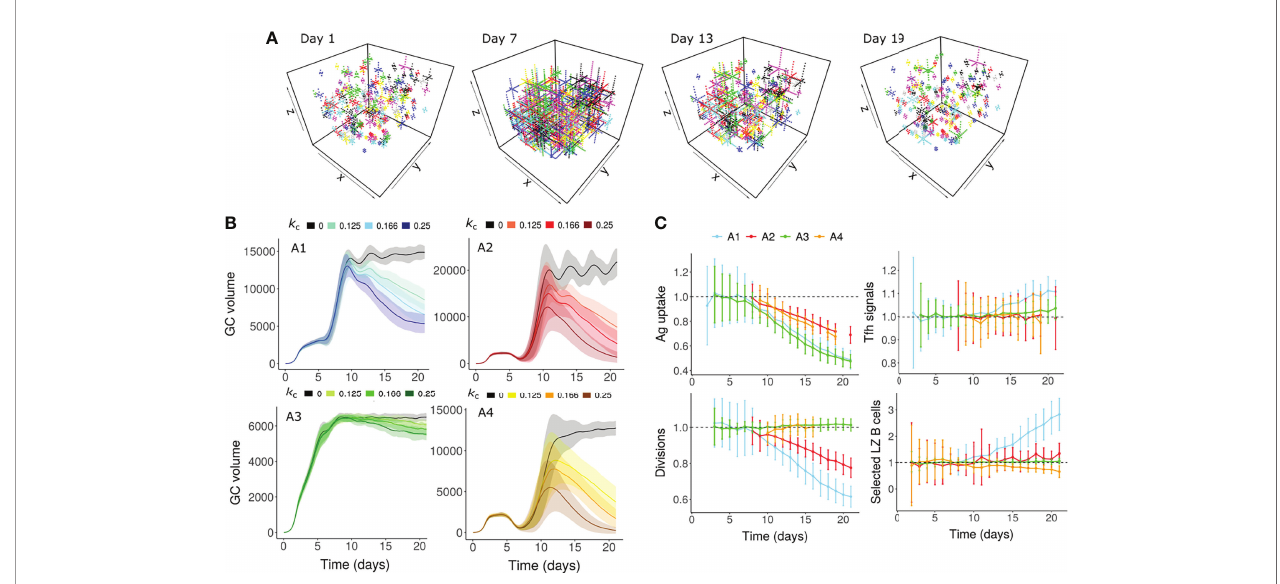
FIGURE 2 | GC shutdown due to contraction of FDCs (Mechanism 3). (A) Visualization of the FDC network in a GC simulation at 4 different time points (Days 1, 7, 13 and 19). In this representative simulation, assumption A1 ( Table 1 ) was used with an FDC contraction rate k c of 0.166 µm per hour. Each lattice site occupied by the FDC is shown as a dot. Soma and dendrites belonging to the same FDC are shown in the same color. (B) GC dynamics with assumptions A1-A4. Black curves represent control simulations. Different colors represent different rates of FDC contraction k c as shown in the labels above panel (B) Solid lines and shaded regions represent mean and standard deviation of 50 simulations, respectively. (C) Average antigen uptake per B cell, Tfh signals acquired per B cell, number of divisions of recycling GC B cells and fraction of Tfh selected LZ B cells. Readouts were normalized with that of the control simulation. Colors represent the assumptions A1-A4. Error bars represent standard deviation of 50 simulations. An FDC contraction rate of 0.166 µm per hour was used in panel (C) In all the panels, FDC extension rate was 0.166 µm per hour. GC, Germinal center; FDC, Follicular Dendritic Cell; Tfh, T follicular helper cell; Ag, Antigen; LZ, Light